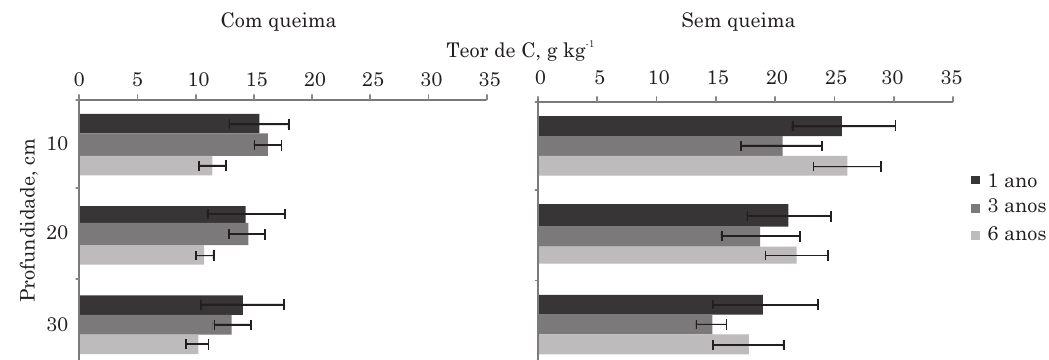
Figura 1. Teores de C no solo em cronossequências de cana-de-açúcar colhida com e sem queima da palha. Barras indicam o intervalo de confiança das médias (p=0,95;